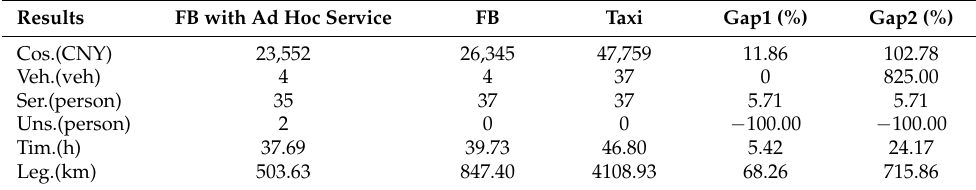
Table 4. Optimized results for various